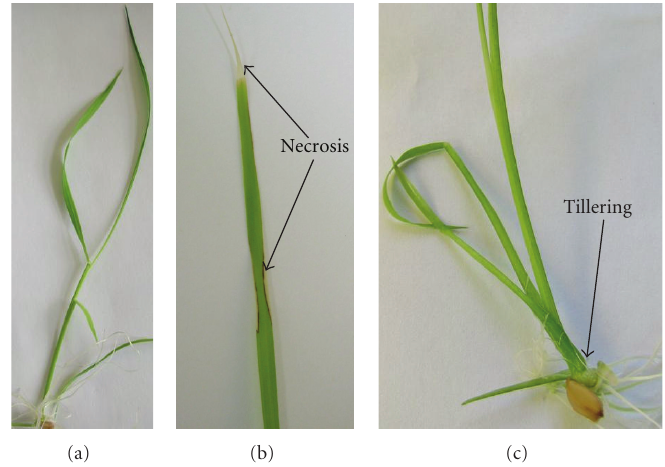
Figure 6: Morphologic alterations in plants ( O. sativa L.) grown in medium with EMVs of A. laidlawii PG8.